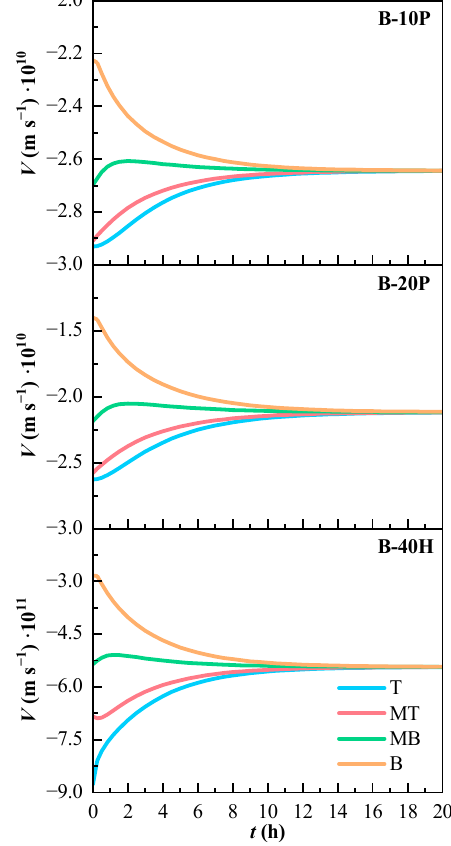
Figure 6. Variation of the estimated convection velocity ( V ) of the binary mixtures over time. T (Top), MT (Medium Top), MB (Medium Bottom), and B (Bottom) correspond to the different heights of the measurement lines.